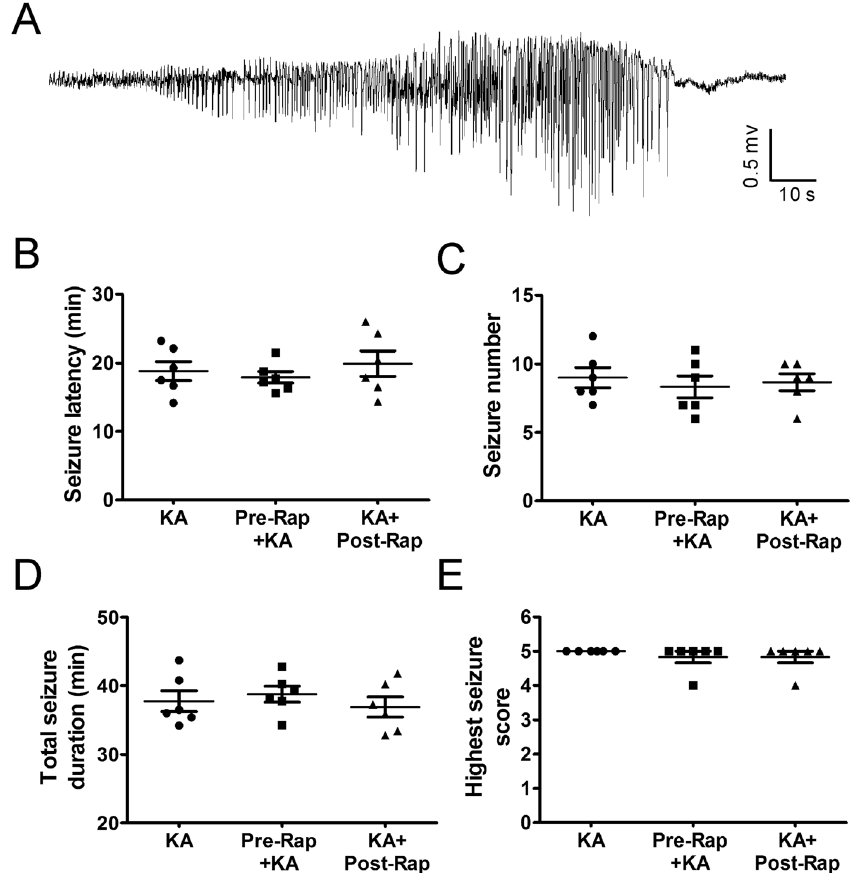
Figure 1. Properties of acute KA-induced status epilepticus and lack of effect of rapamycin pre-treatment. ( A ) Representative electrographic seizure following KA injection. ( B–E ) Rapamycin pre-treatment (6 mg/kg, i.p., 48 hr and 24 hr prior to KA) and post-treatment (6 mg/kg i.p., daily for one week, starting immediately after seizure termination) have no effect on the properties of seizure latency, number, duration, and severity during the acute episode of KA-induced status epilepticus (defined as > 30 min of cumulative electrographic seizures). (n = 6 per group; One-way ANOVA with Tukey’s test, p >